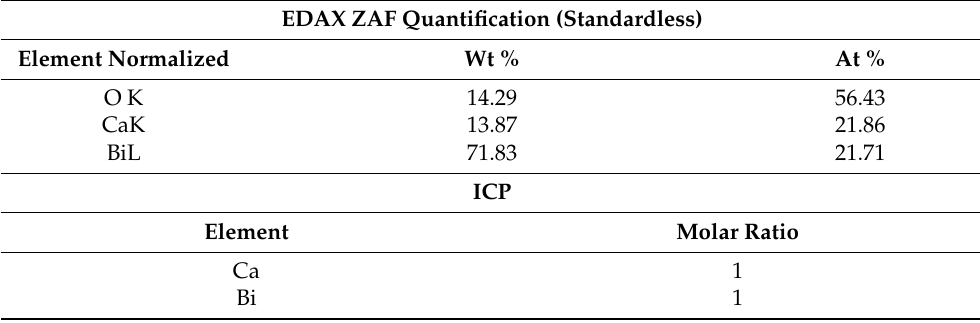
Table 2. The sample’s energy dispersive spectral examination at several sites, verified by ZAF quantification and ICP